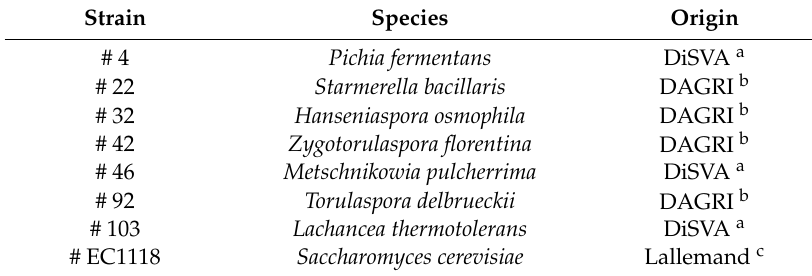
Table 1. Origin of the seven non- Saccharomyces strains and the commercial strain of S. cerevisiae used in this study. Strain Species Origin #